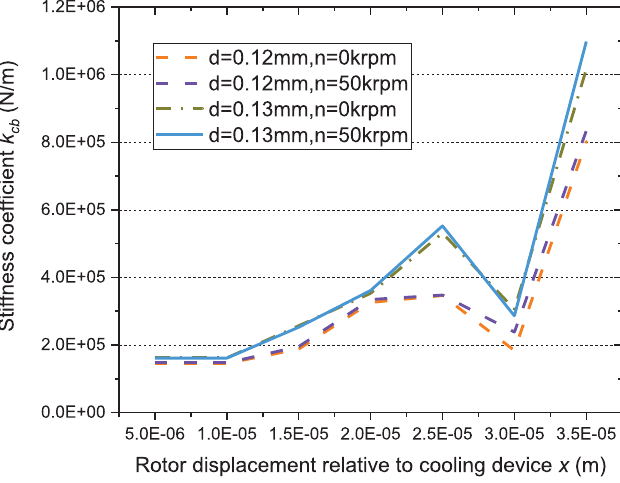
Fig.8. Stiffness coef fi cient k cb versus mass fl ow rate Q of the ori fi ce.